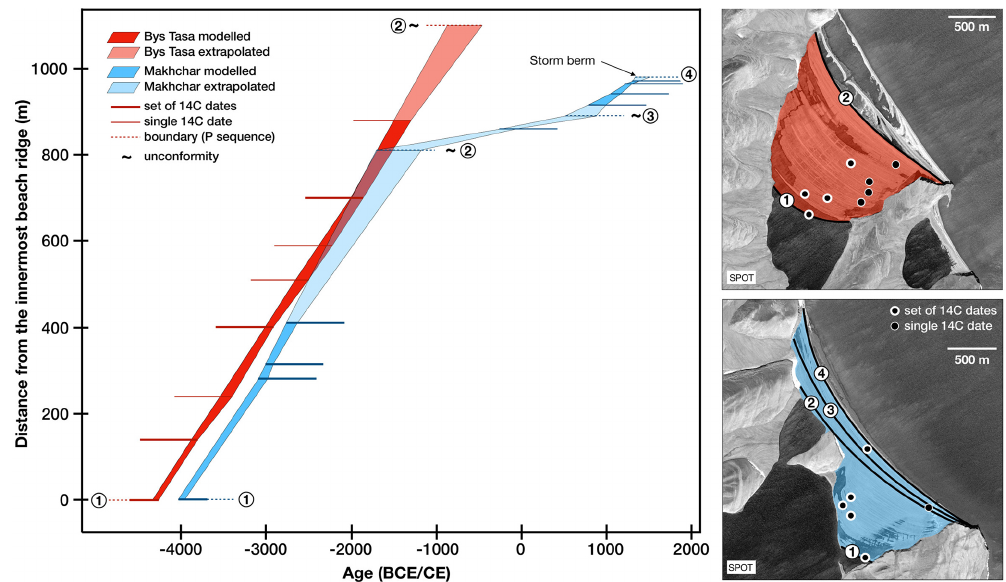
Figure 3. Age–distance models for the progradation of the two beach-ridge systems. Solid lines mark the position of samples and sample sets. The circled numbers on the right indicate the location of boundaries in the P sequence as the first and last preserved ridges and unconformities in the pattern of progradation. The black circles indicate the location of individual samples and sample sets (see Fig. 2 and Tables 1 and 2 for further details). Background data: SPOT7; ©Airbus DS